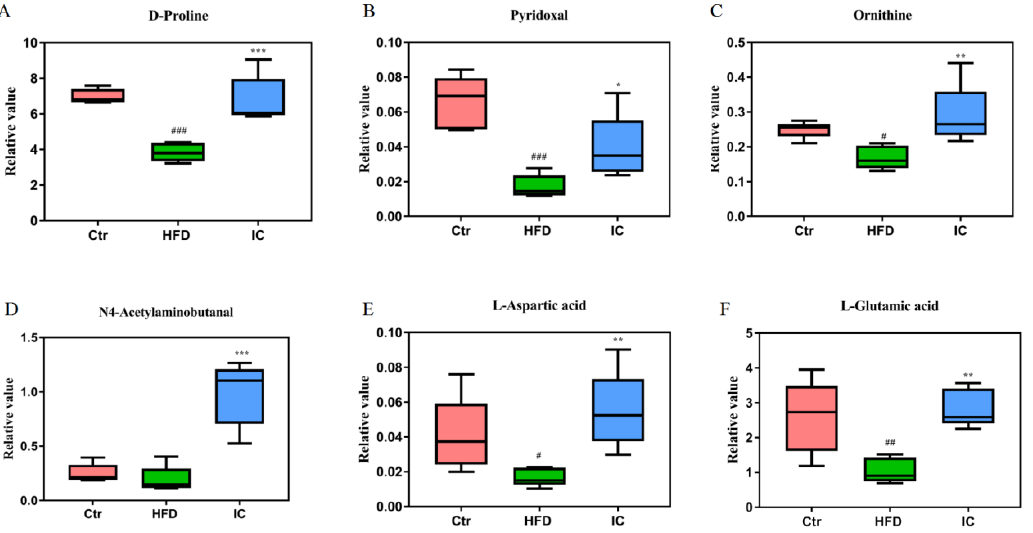
Figure 9. Six representative differentially expressed metabolites D-Proline ( A ), Pyridoxal ( B ), Ornithine ( C ), N4-Acetylaminobutanal ( D ), L-Aspartic acid ( E ) and L-Glutamic acid ( F ) ### p < 0.001, ## p < 0.01, # p < 0.05, versus the control group; *** p < 0.01, ** p < 0.01, * p < 0.05, versus the HFD group.